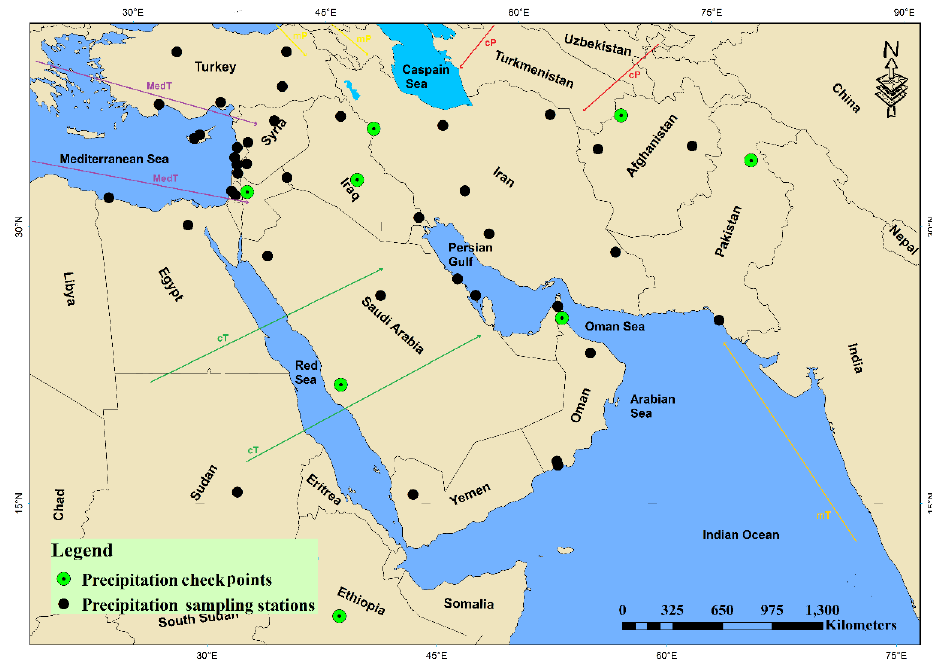
Figure 1. The map of the Middle East including the precipitation sampling stations, the precipitation checkpoint stations, and the main air masses affecting it.